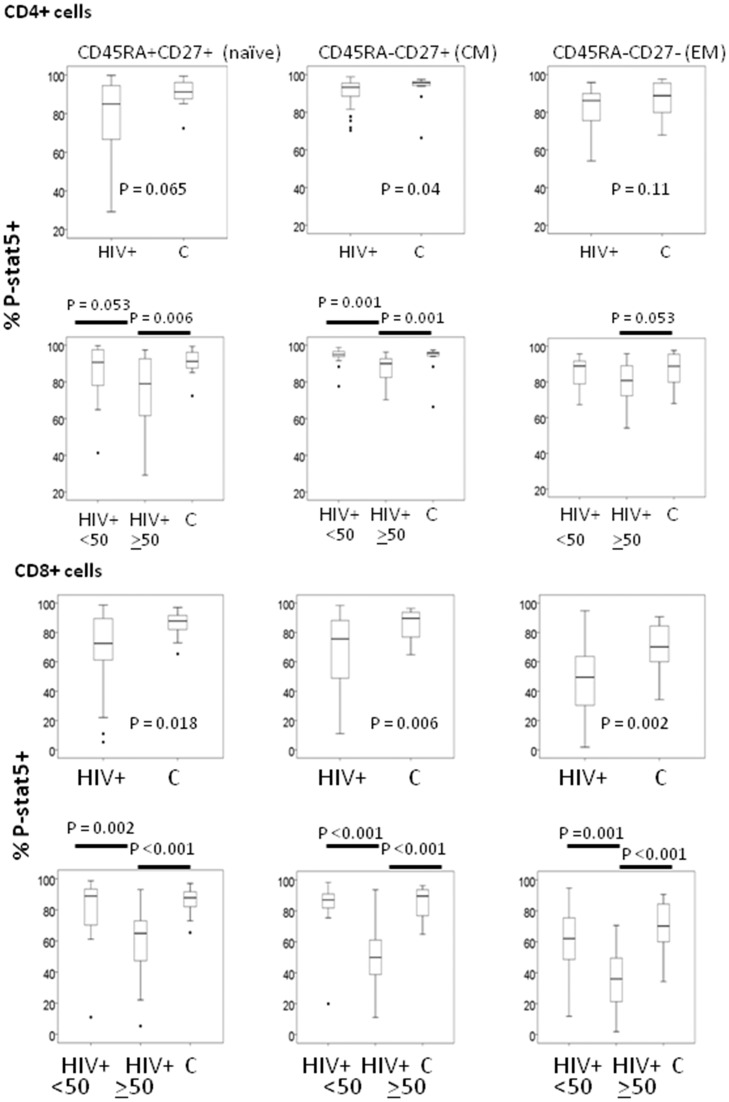
Diminished IL-7 induction of P-STAT5 in T cell subsets from HIV+ donors.PBMC were incubated for 15 min with rIL-7 (1 ng/ml) and cells were assessed by flow cyomtery for expression of P-STAT5. Responses of CD4 lymphocytes (A and B) and CD8 lymphocytes (C and D) are shown as box-and-whiskers plots indicating the median, the inter-quartile values (box), the range (whiskers) and the outliers (symbols). Data are represented for all HIV+ donors (A and C) or for viremic and aviremic donors (B and D). The percentage of P-STAT5 expression represents the percentages of P-STAT5+ cells that increased P-STAT5 expression above levels observed in unstimulated cells.